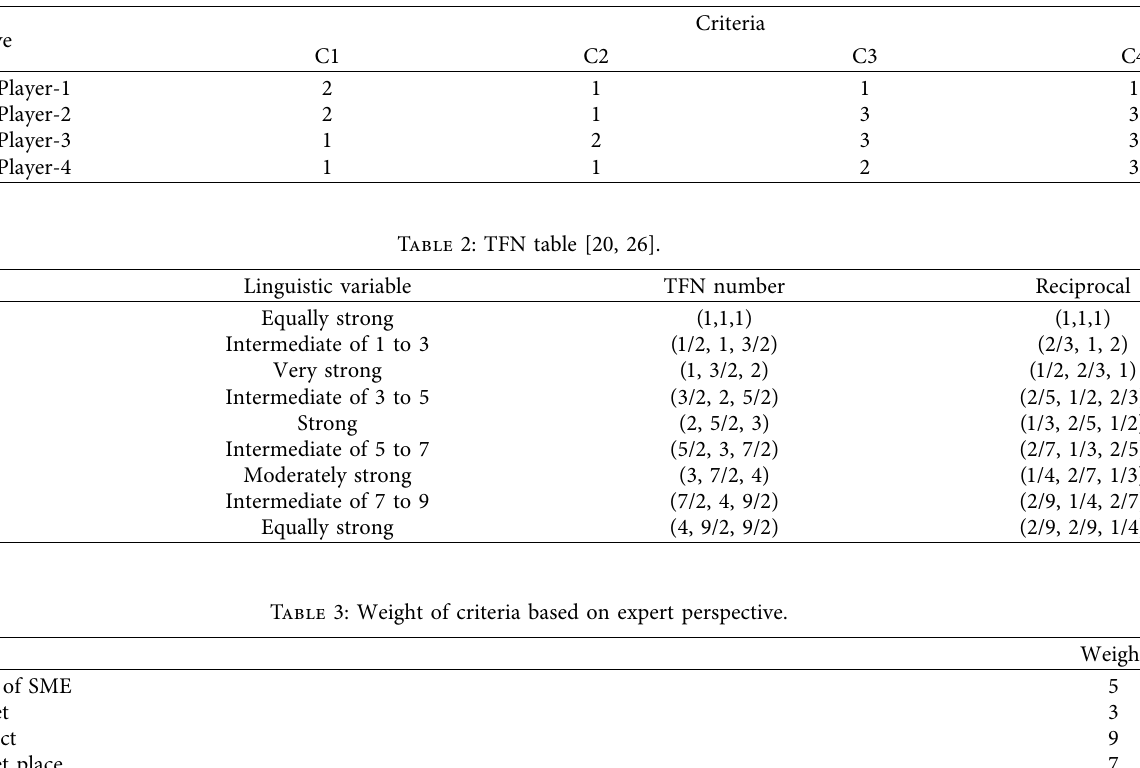
Table 1: Dummy data of SME identity.